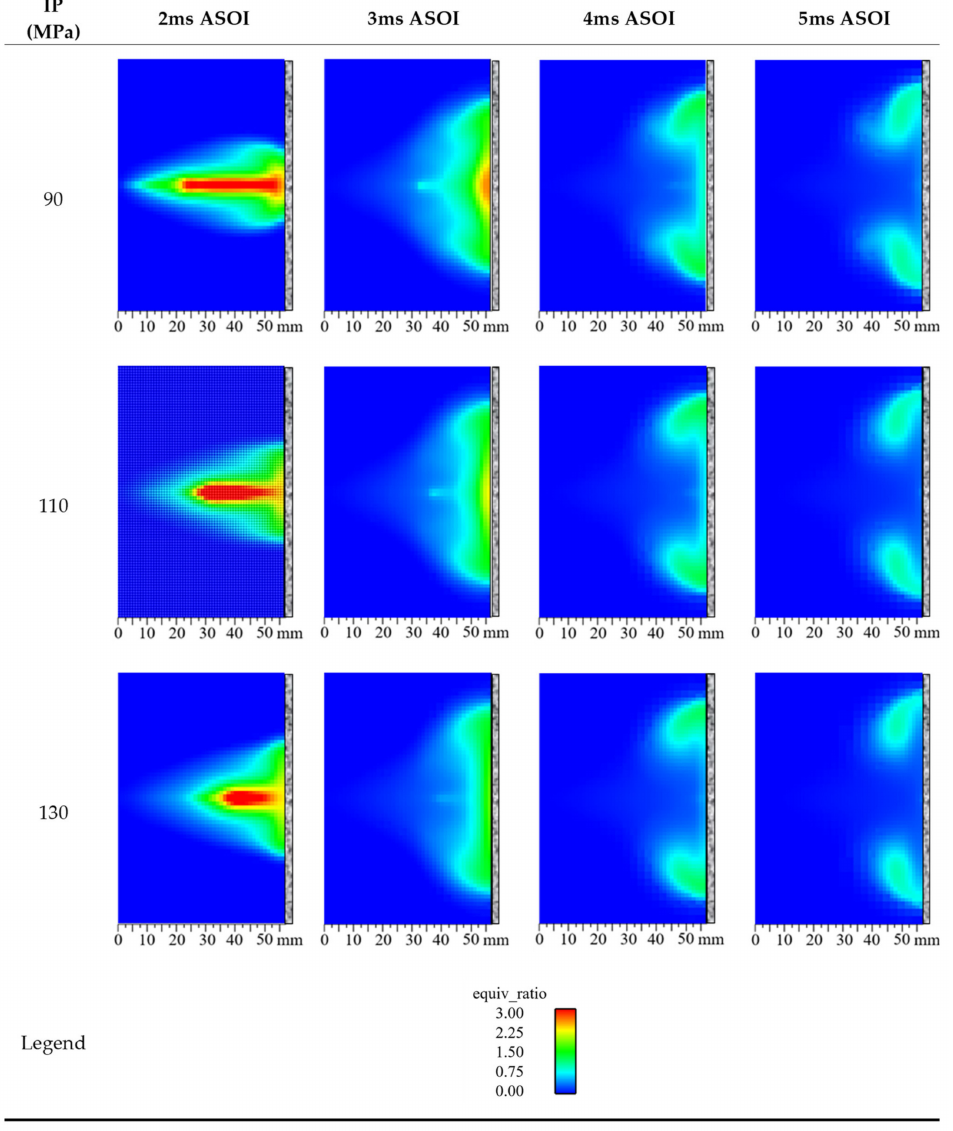
Figure 17. Simulation results of the equivalence ratio under di ff erent injection pressures. The mixture process under di ff erent injection pressures is approximately the same as the flame di ff usion by the